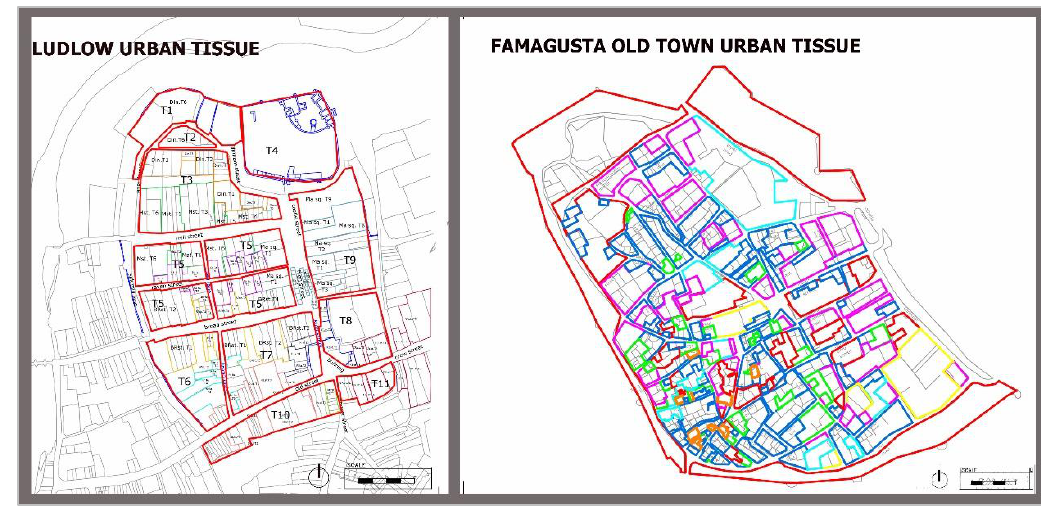
Figure 3 Ludlow and Famagusta Old Town Urban Tissues